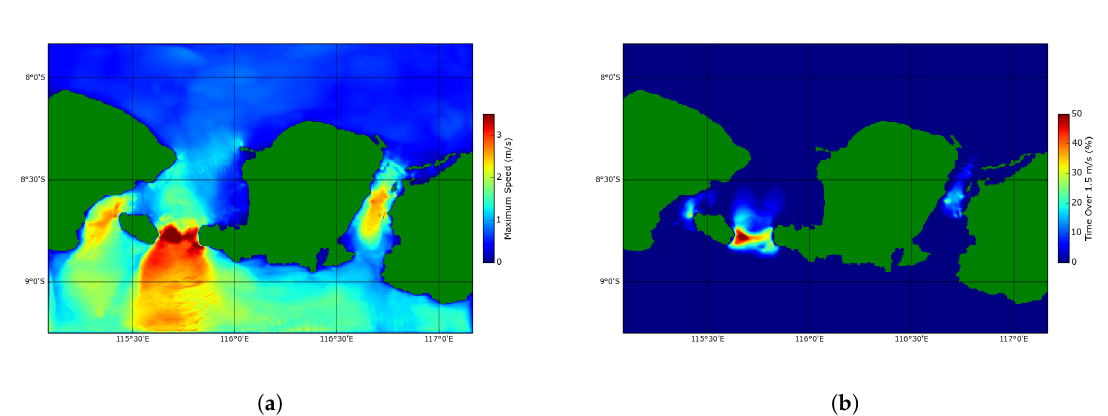
Figure 8. ( a ) The maximum surface flow speed; ( b ) % of time velocities are greater than 1.5